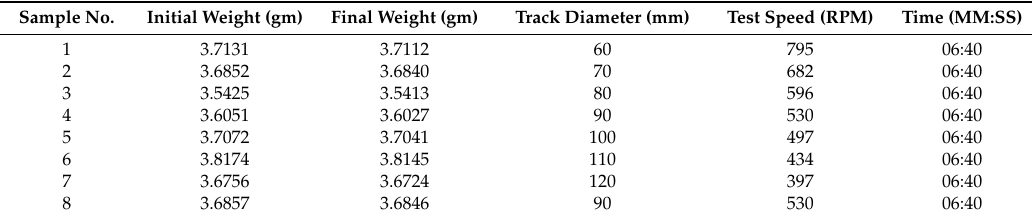
Table A1. Wear loss of samples (Sliding Velocity: 2.5 m/s, Load: 20 N, Sliding Distance: 1000 m). Sample No.